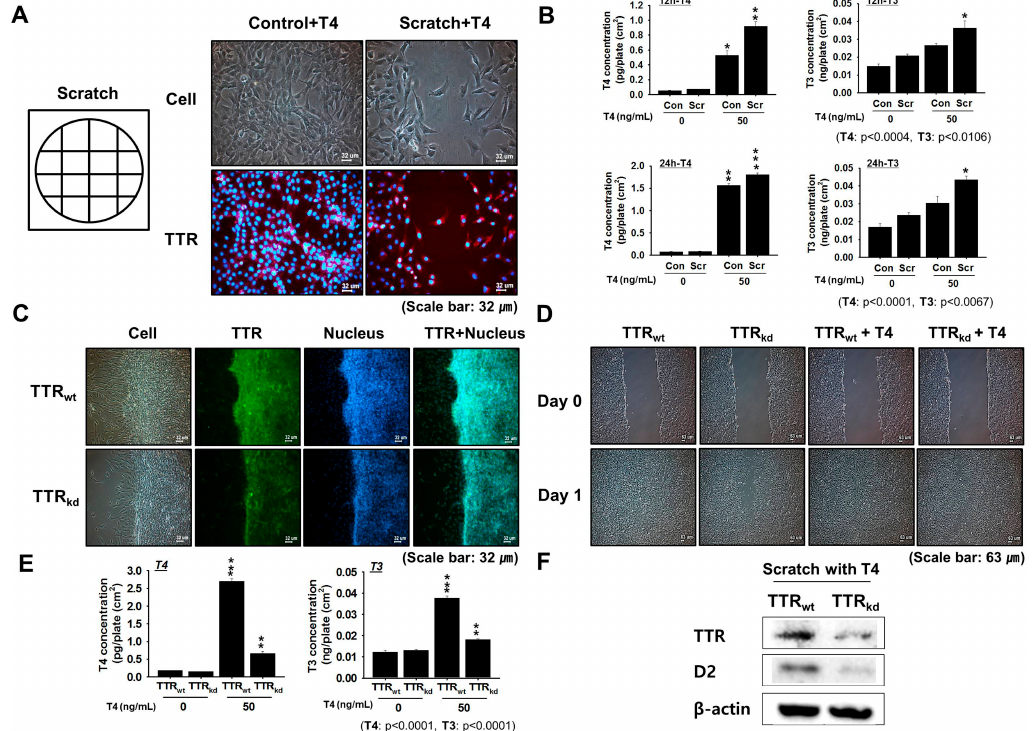
Figure 2. Effect of TTR knock-down on cell migration. Scratch testing was used to examine differences in cell migration. ( A ) TTR protein expression of control and scratched cells in the presence of T4 (red: TTR; blue: nucleus); ( B ) Difference in T3 and free T4 concentrations in normal and scratched samples at 12 or 24 h after T4 supplementation; ( C ) Analysis of scratched scrambled vector (control: TTR wt ) and TTR shRNA transfected cells (TTR kd ) conducted by staining with TTR antibody followed by 4 ′ ,6 ′ -diamino-2-phenylindole (DAPI) nuclear staining (green: TTR; blue: nucleus); ( D ) Differences between the migration patterns of TTR wt and TTR kd cells in the presence or absence of T4; ( E ) Estimation of free T4 and T3 hormone levels in scratched and non-scratched cells in TTR wt and TTR kd cell cultures with or without T4 supplementation; ( F ) TTR and D2 protein expression was analyzed by Western blotting of TTR wt and TTR kd cells supplemented with T4. p -values indicate statistical significance of the data (mean ± S.D., n = 3, *: p < 0.05, **: p < 0.001, ***: p < 0.0001).